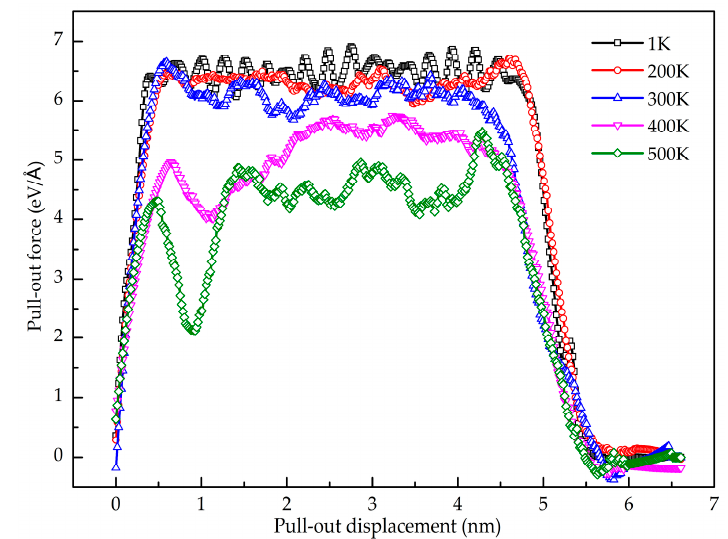
Figure 10. Pull-out force as a function of displacement at different temperature.